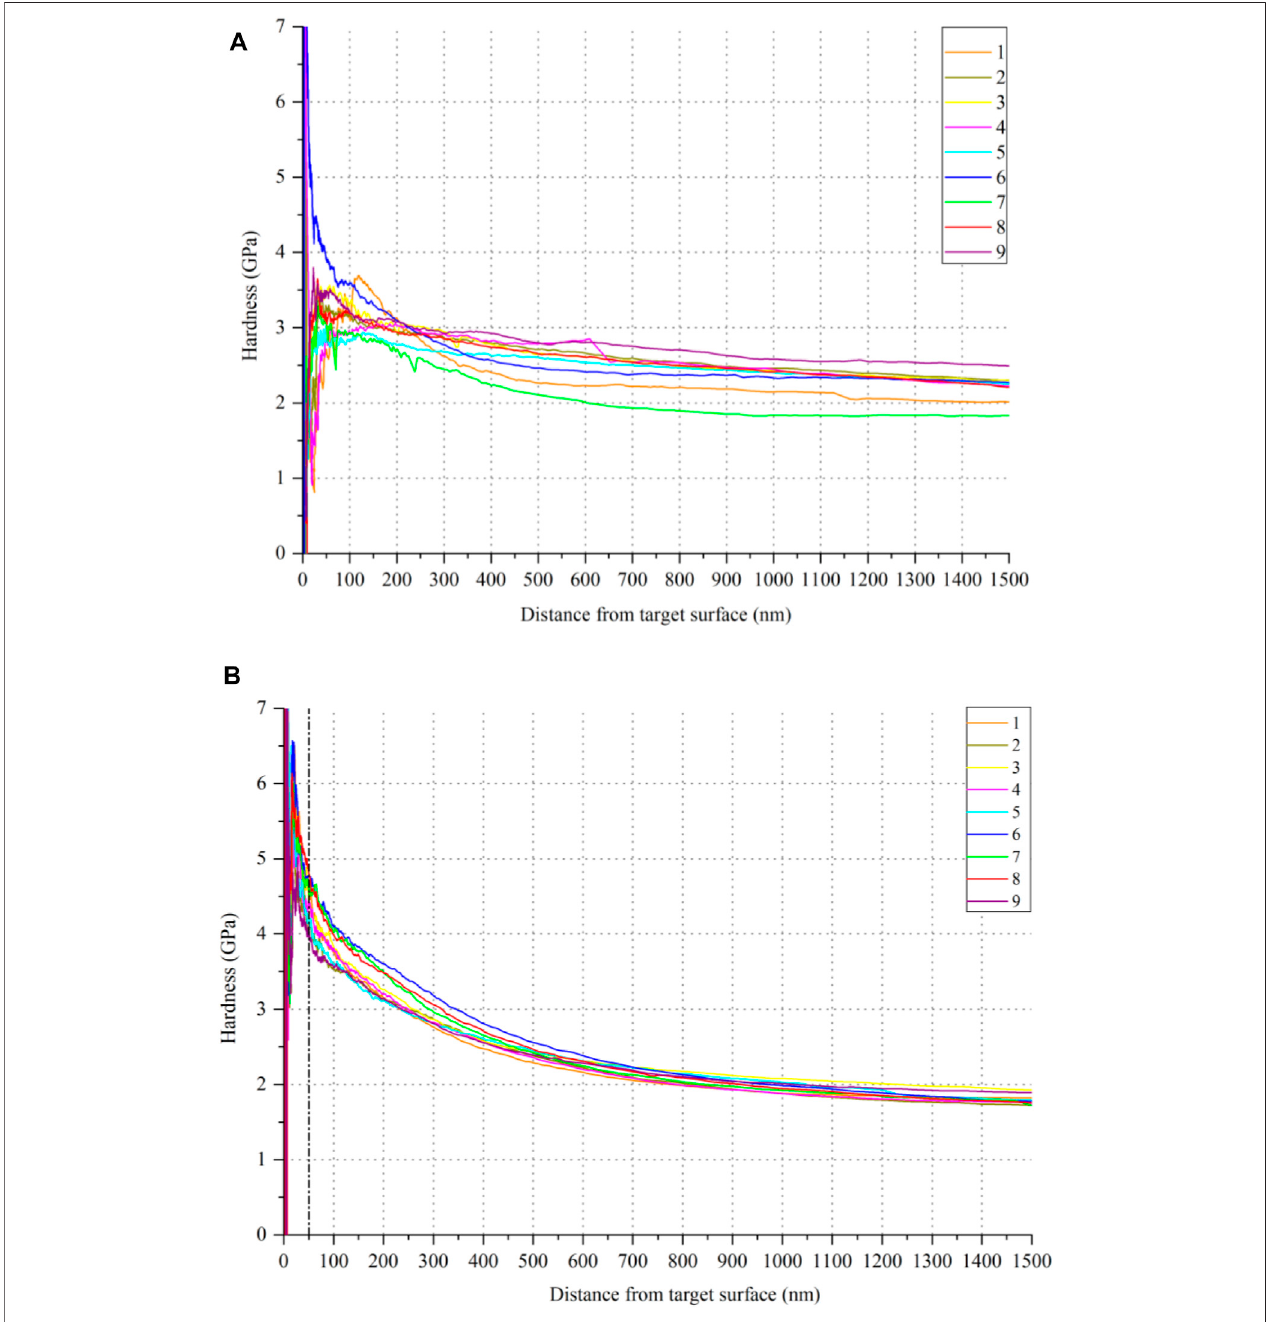
FIGURE 6 | (A) Hardness test results without optimization and (B) hardness test results after